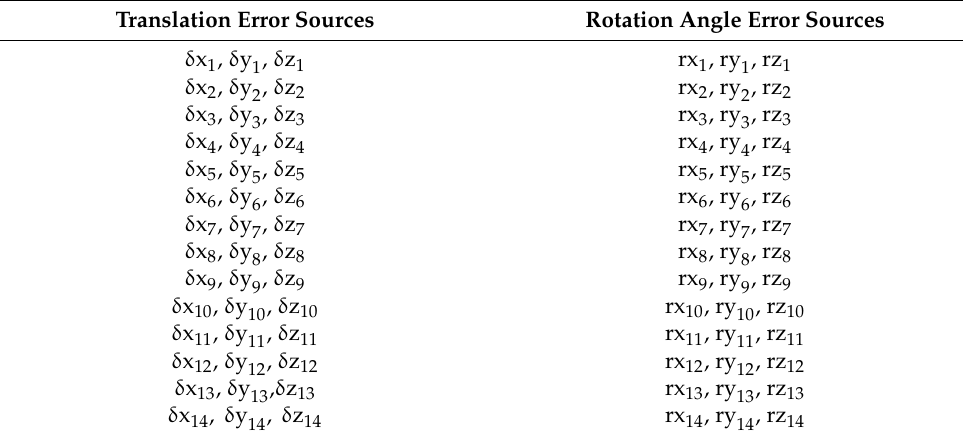
Table 2. Motion error parameters of platform due to ballscrew nut